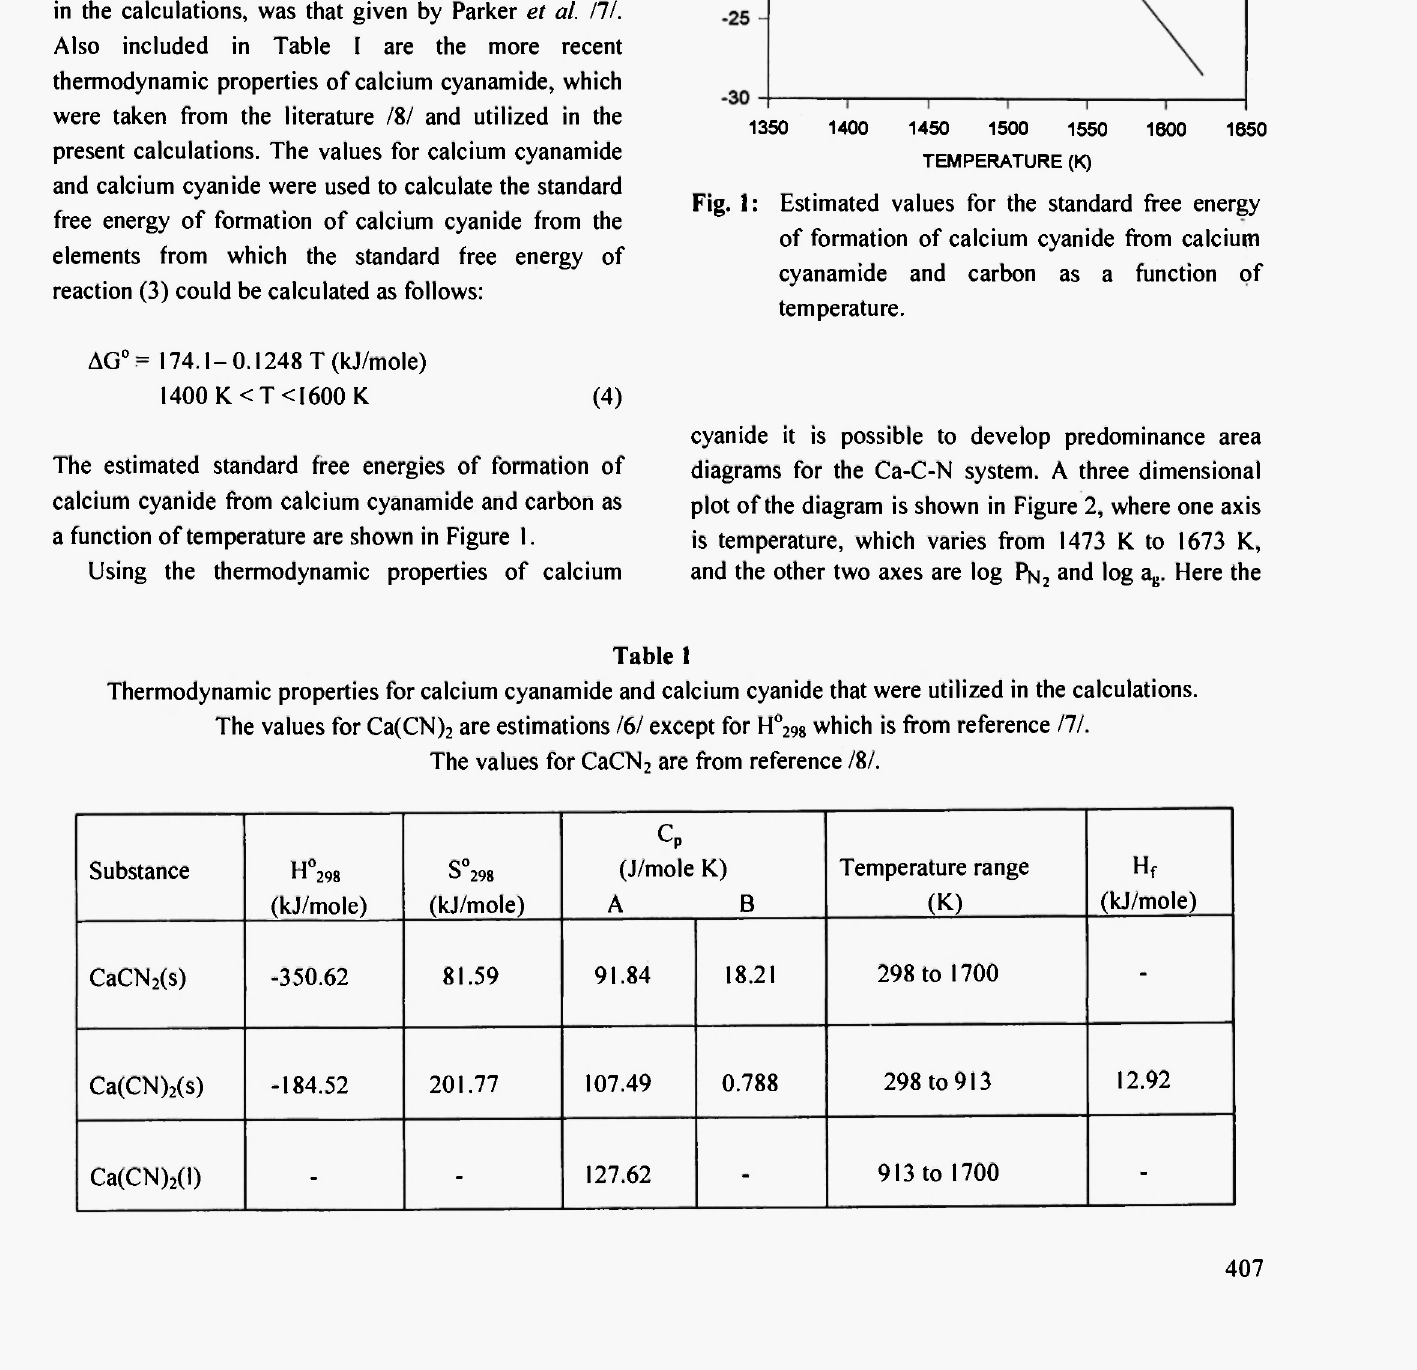
Fig. 1: Estimated values for the standard free energy of formation of calcium cyanide from calcium cyanamide and carbon as a function of